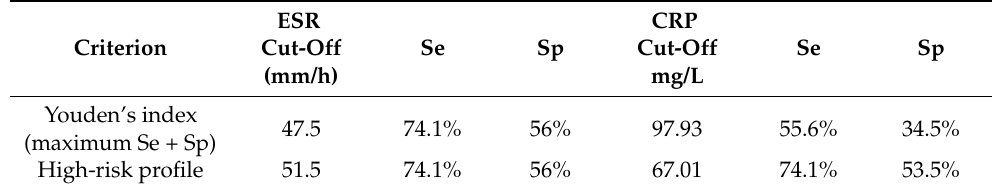
Table 10. Cut-off values for ESR and